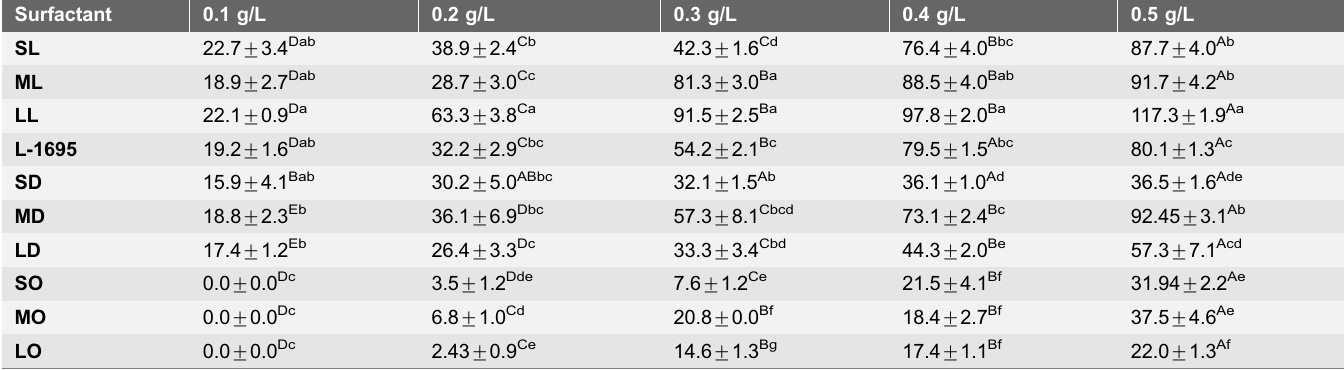
Table 2. Foamability (%) of different esters at different concentrations a .